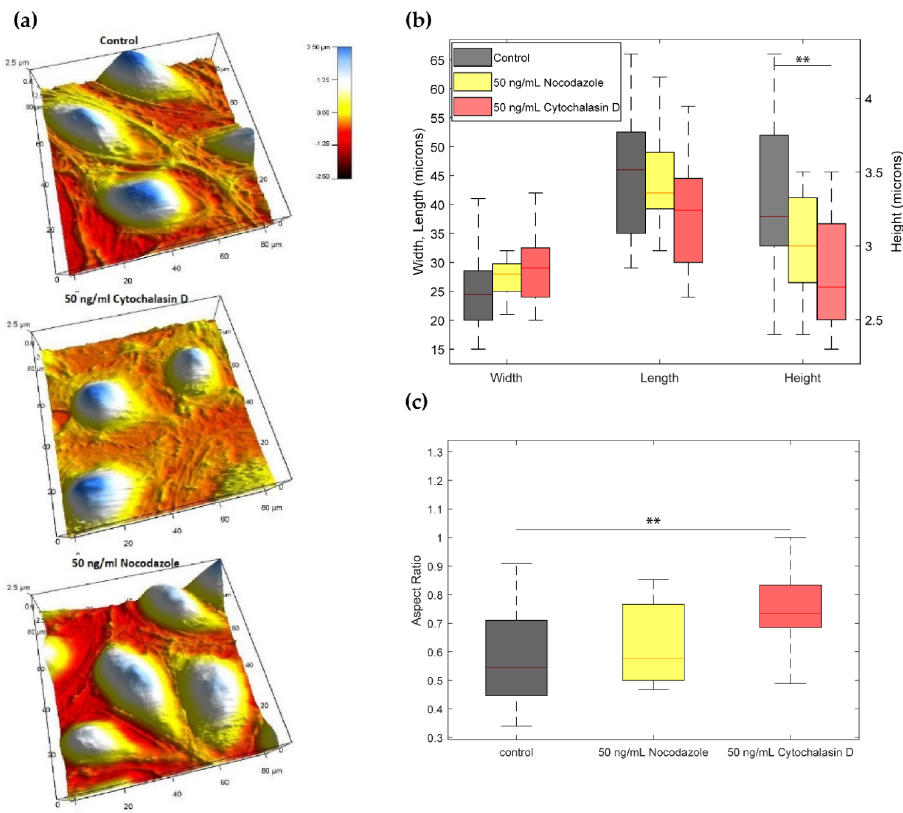
Figure 6. ( a ) Topographical images of cells taken with the Atomic Force Microscope. Cytochalasin D and nocodazole treatments were administered to cells four hours before imaging. ( b ) Measurements of length, width, and height from topographical images. ( c ) Aspect Ratio ( width/length ) calculations from width and length measurements of HUVECs. Within each box in the box and whisker plots, the horizontal lines denote median values; boxes extend from the 25th to the 75th percentile of each group’s distribution of values. Comparisons were carried out with a one ‐ way ANOVA test. p ‐ values were then calculated with a multi ‐ comparison test (** p < 0.01).